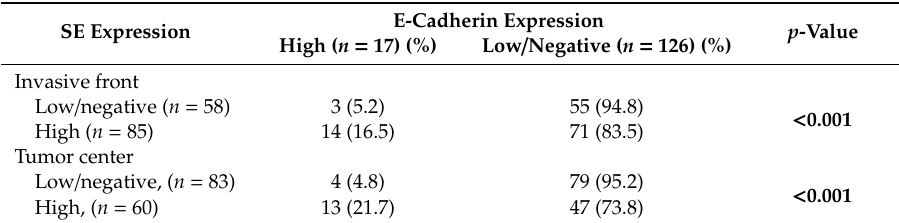
Table 2. Comparison of expression between SE and E-cadherin in CRC.